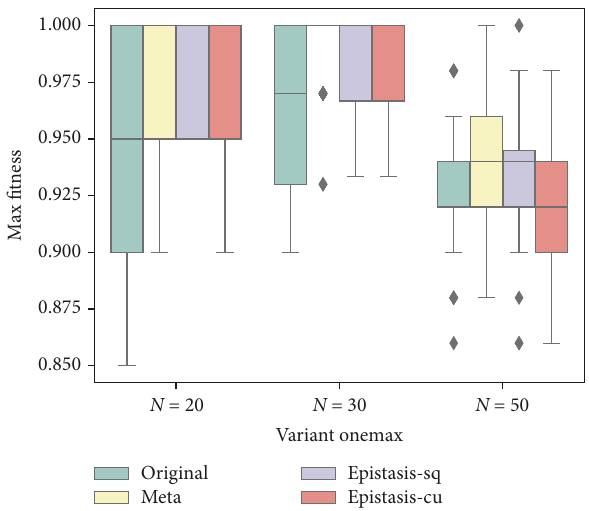
Figure 3: A box plot of each of the best solutions obtained by conducting the GA experiment 100 times on an instance of the variant-onemax